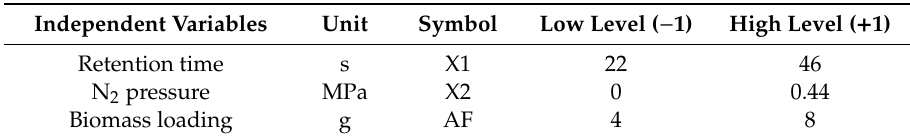
Table 4. The chemical composition of steam-exploded